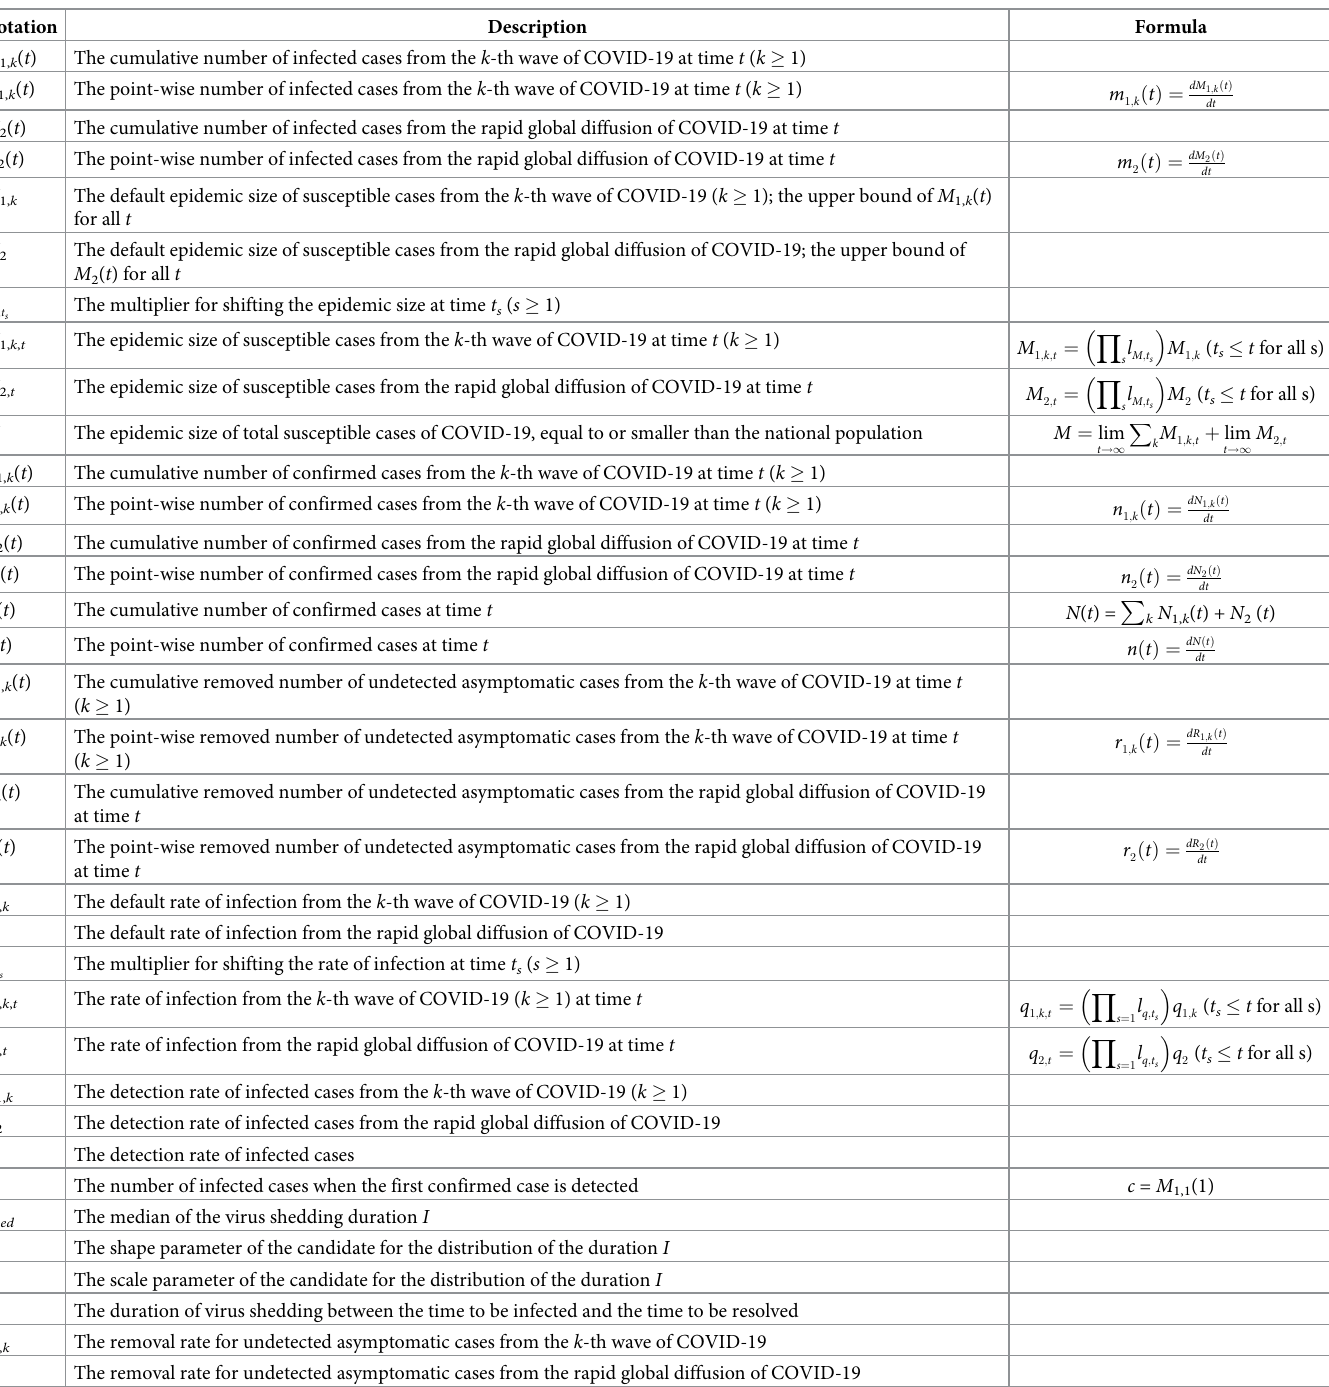
The rate of infection is compatible with the direct/indirect contact with infectious cases. The rate of infection can be accepted as the degree of social distancing; the lower rate of infec- tion, the more effective social distancing. From Muller et al. [24], the Bass model